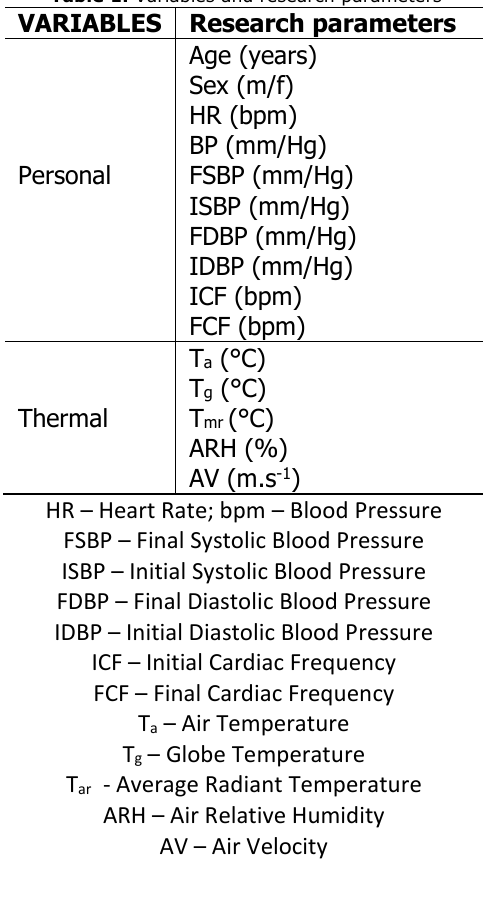
Table 1. Variables and research